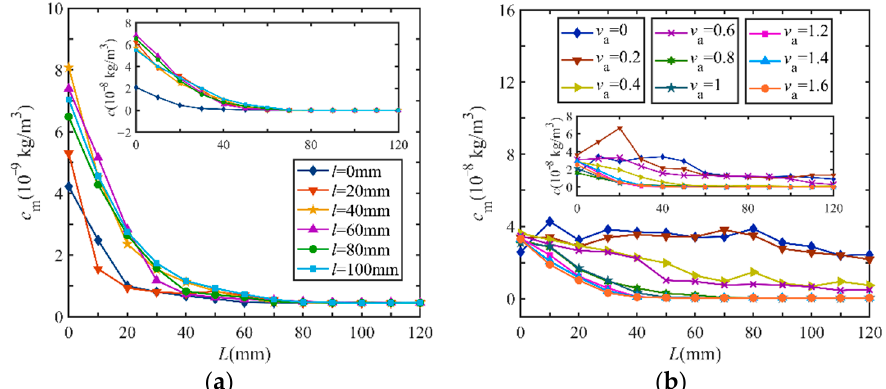
c of the large-aperture channel for the experimental measurement Figure 11. Variation curves of Figure 11. Variation curves of c m of the large-aperture channel for the experimental measurement of m the different blowing scheme. ( a ) The c m variation curves with L for different l ; ( b ) the c m variation c variation curves with L for different l ; ( b ) the of the different blowing scheme. ( a ) The m curves with L for different v a . v . variation curves with L for different a